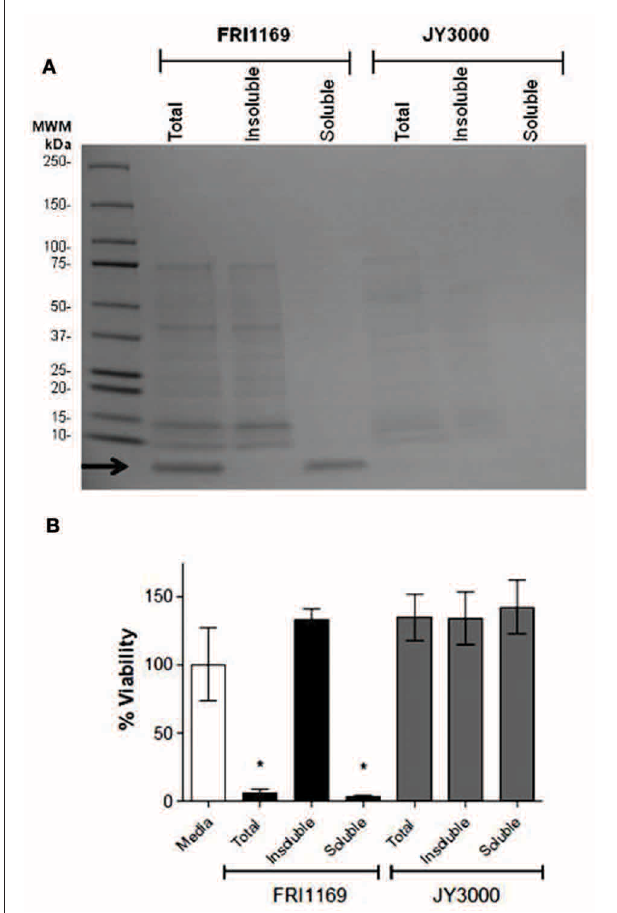
FIGURE 3 | Ethanol (80%) separation of exoprotein and determination of cytotoxicity. (A) 14 and 7h broth culture supernatant fluids (20 μ g of protein was loaded per lane) were treated with 80% (final concentration) ethanol and total, ethanol-insoluble, and ethanol-soluble fractions were separated by SDS-PAGE and Coomassie brilliant blue-stained. Arrow denotes small molecular weight ( < 10kDa) band only present in total supernatant fluid or ethanol soluble fraction of FRI1169 culture (B) A549 cells were exposed to total, ethanol insoluble, and ethanol soluble fractions of FRI1169 and JY3000. Cytotoxicity was measured and plotted relative to media only (untreated) control. ( ∗ Indicates P < 0 . 05 relative to media control).